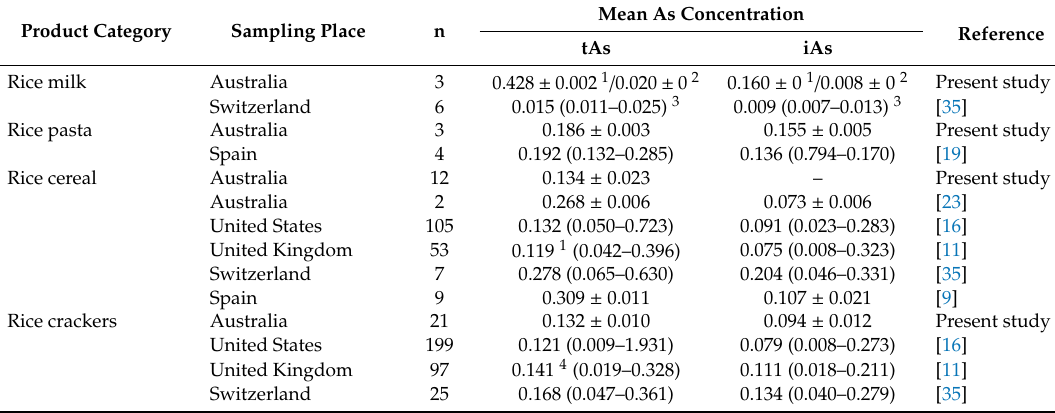
Table 3. Comparison of tAs and iAs concentrations (mg kg − 1 ) in infant rice-based foods in the current study and the published literature (values are mean ± standard error, range in